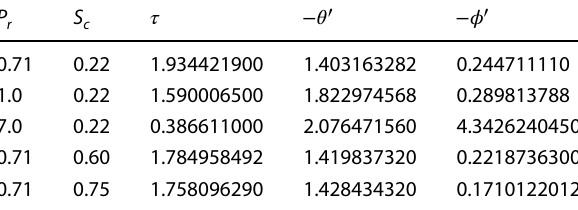
Table 3 Computed values for the local skin friction, rate of heat transfer, and rate of mass transfer for different values of P r and S c